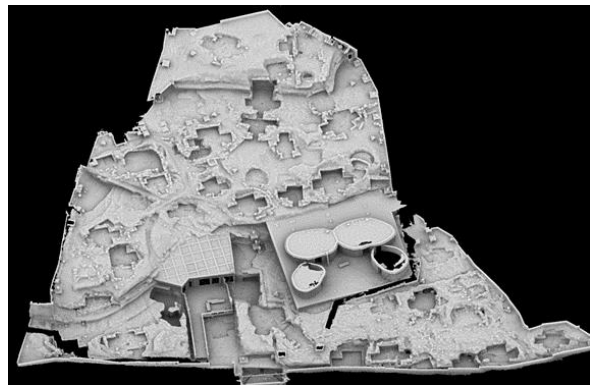
Figure 10. General view of the laser model.